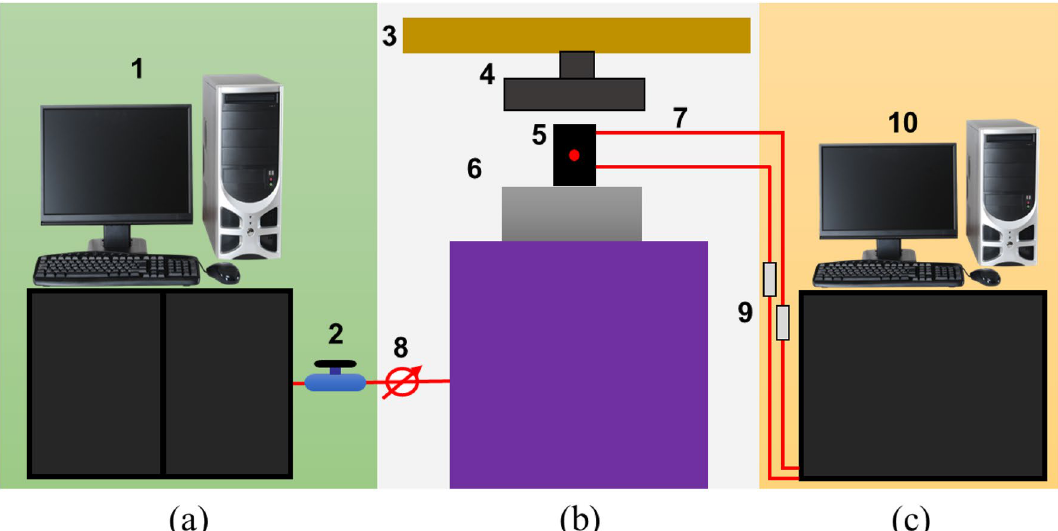
Figure 3. Systematic diagram experimental system. ( a ) Loading controls system includes (1) system for loading control (2) valve ( b ) AE signals collecting and a loading system consists of (3) Serve hydraulics press, (4) Press head, (5) coal sample, (6) AE Sensor, (7) connecting wires (8) Pressure gauge; ( c ) AE and EMR data processing and storage system comprises (9) pre-amplifiers, (10) system screen to display data and (11) AE monitoring